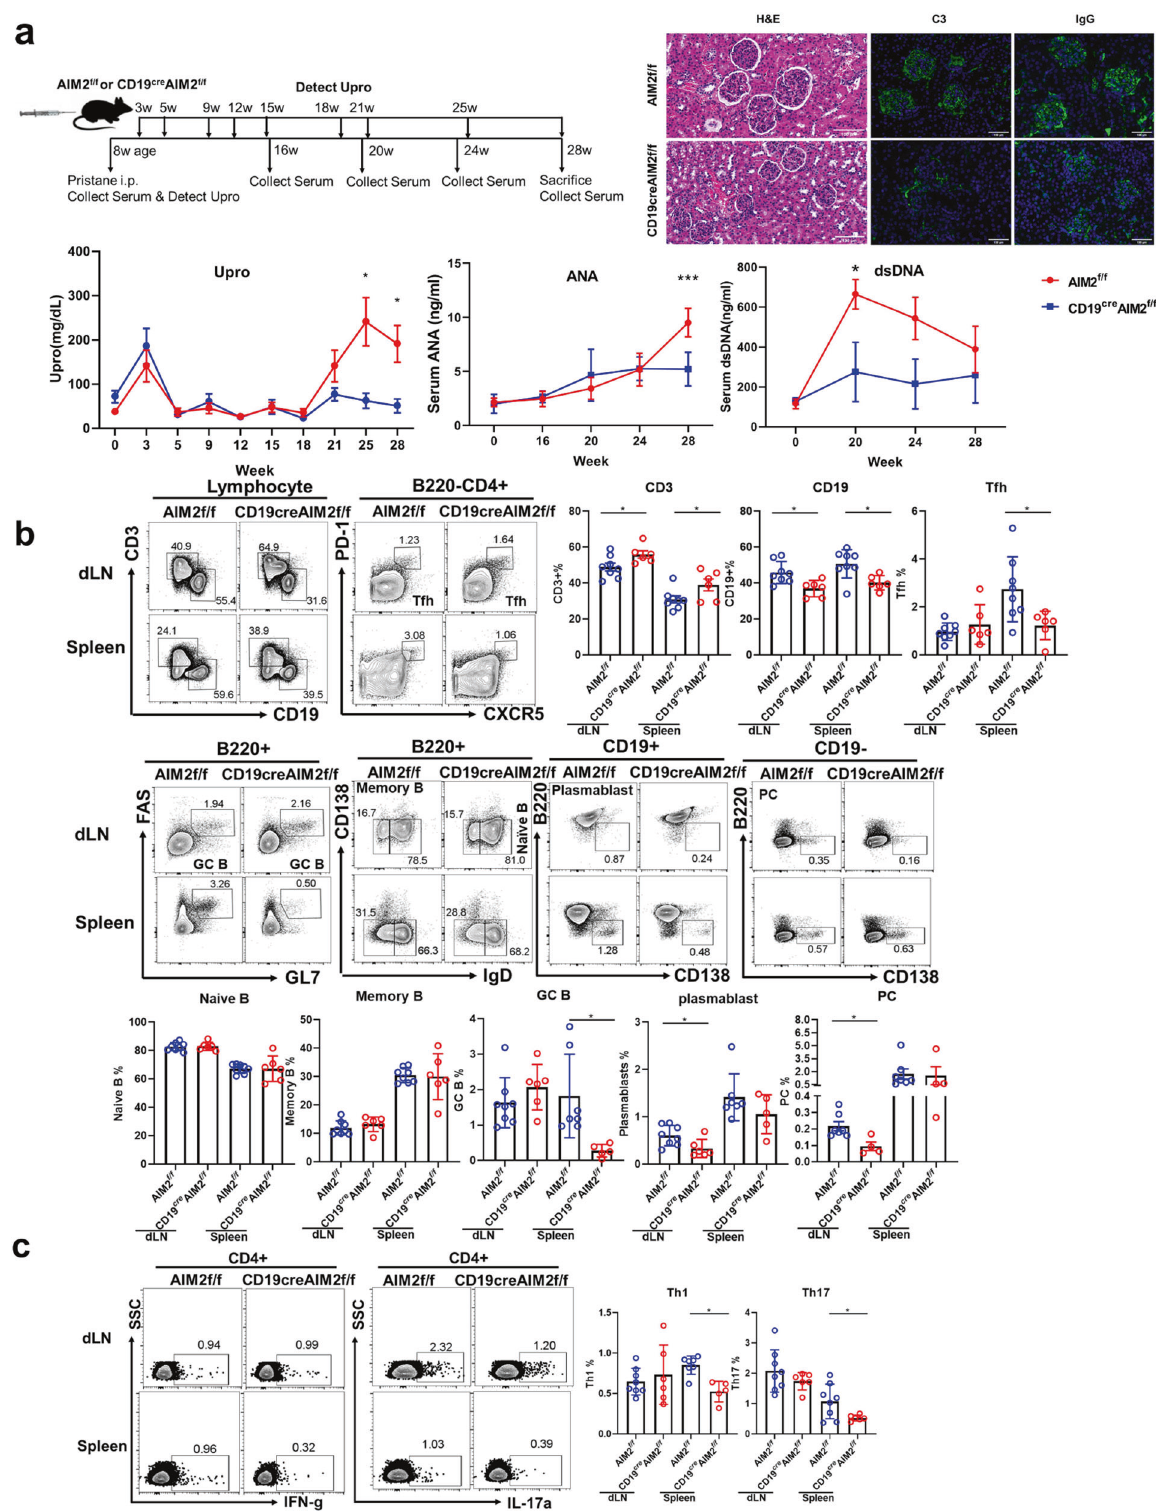
Fig. 4 Pristane-induced lupus mouse in CD19 cre AIM2 f/f mice. a A schematic of the induction of lupus in mice by pristane. H&E staining, C3 and IgG deposition in the kidney, proteinuria, and serum levels of ANAs and anti-dsDNA antibodies were shown. b Representative fl ow cytometry diagrams and statistical analysis of the frequencies of CD3 cells, CD19 cells, Tfh cells, naive B cells, memory B cells, GC B cells, plasmablast, and plasma cells in the dLNs and spleens of the CD19 cre AIM2 f/f mice and AIM2 f/f mice. c Representative fl ow cytometry diagrams and statistical analysis of the frequencies of Th1 and Th17 cells in the dLNs and spleens of the CD19 cre AIM2 f/f mice and AIM2 f/f mice. Horizontal bars represent the mean ± SEM. * p < 0.05, *** p < 0.005